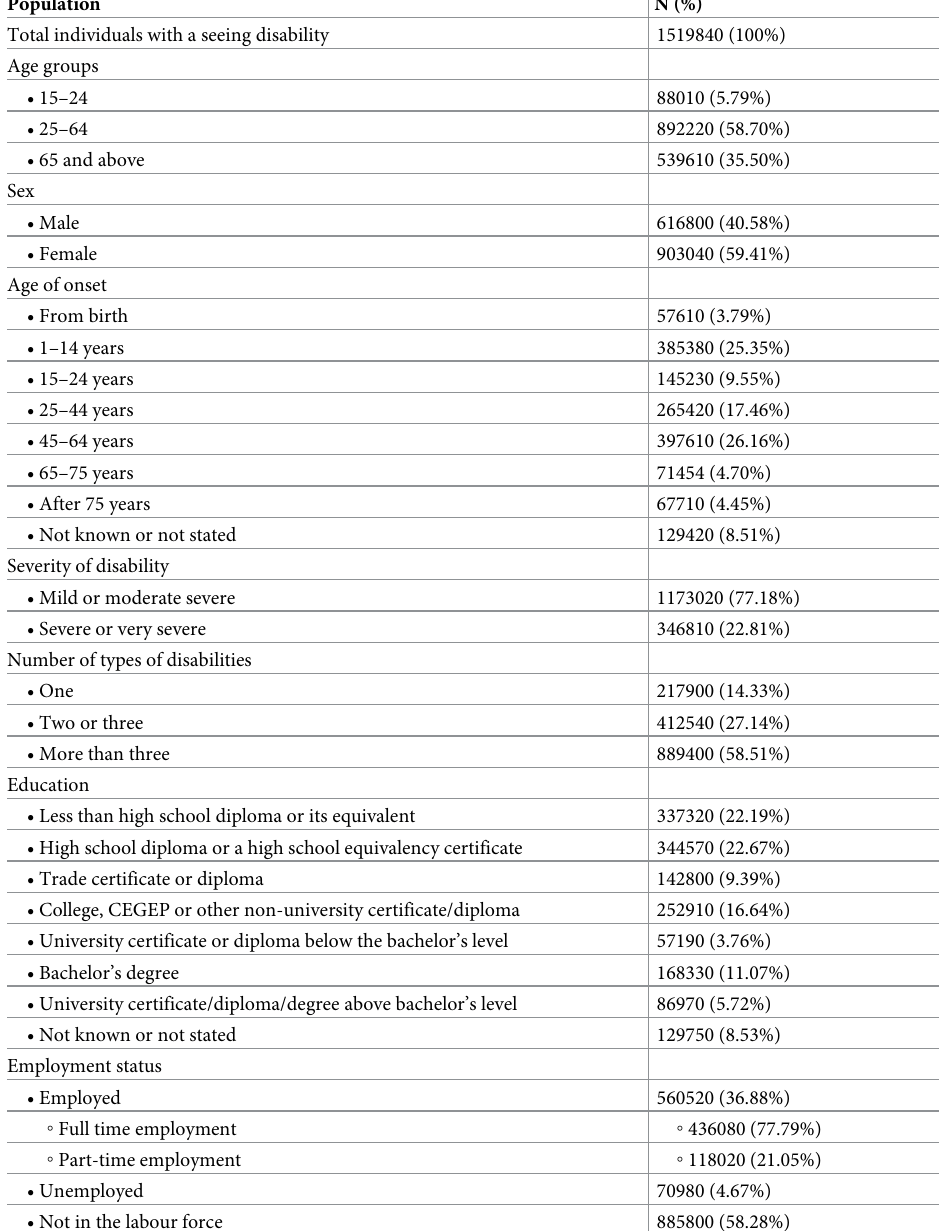
Table 1. Demographic profile of persons with seeing disability in Canada, 2017 (N = 1,519,840). Population N (%) Total individuals with a seeing disability 1519840